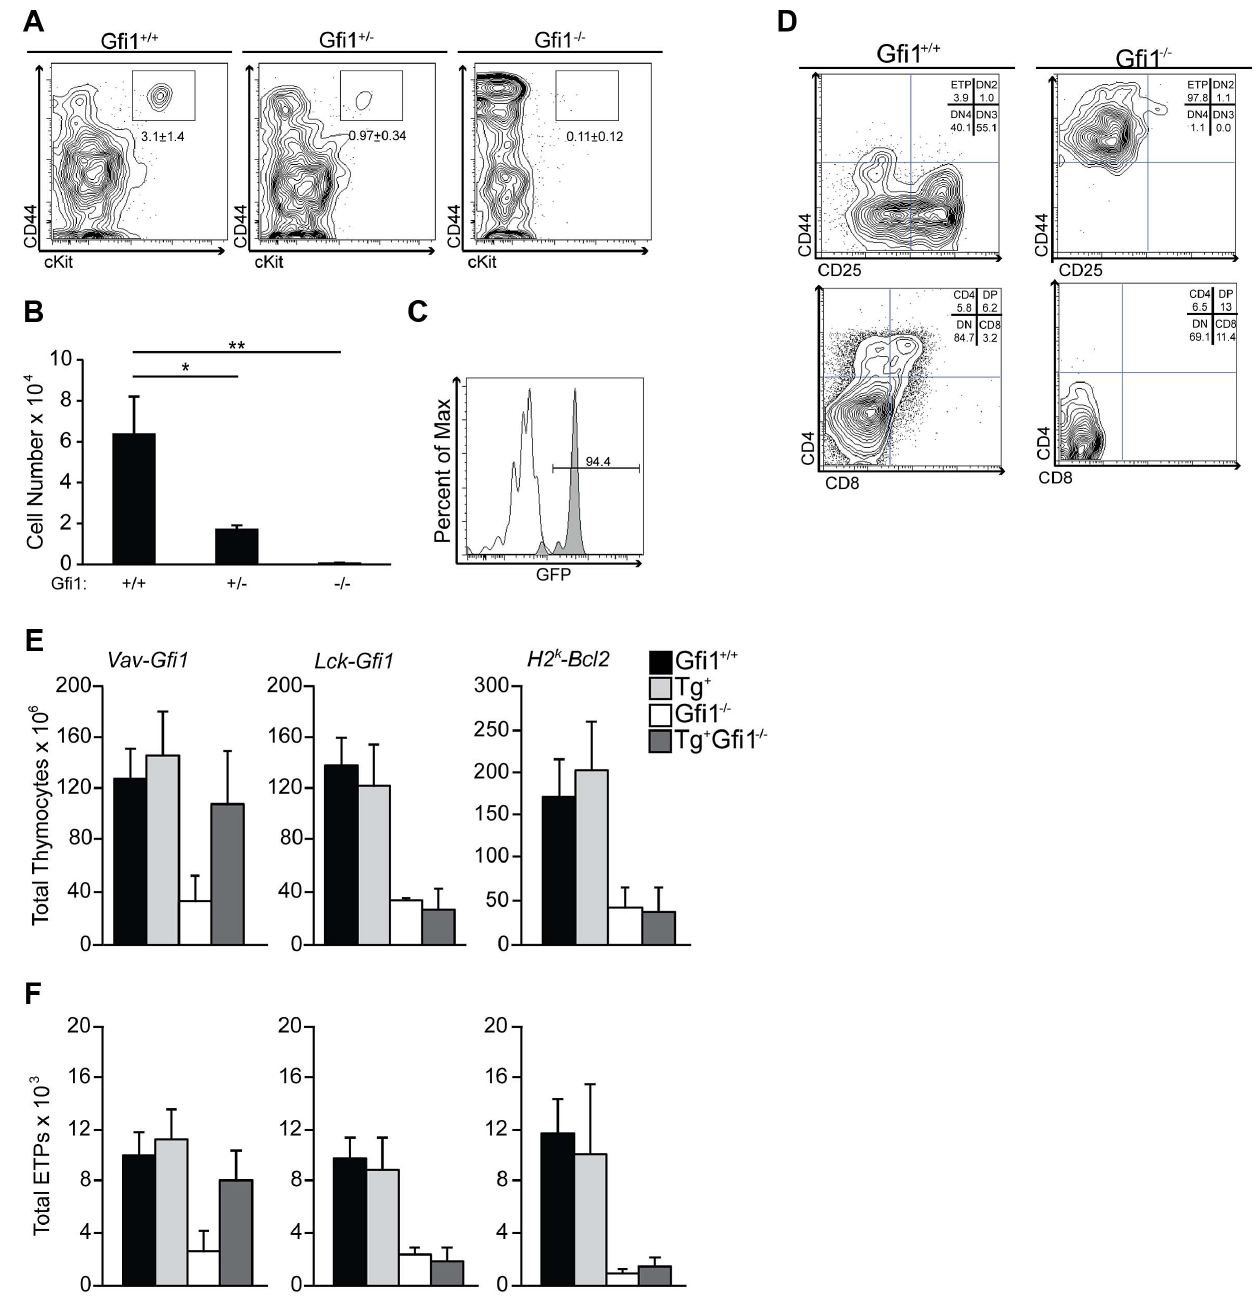
Figure 4. Gfi1 deficiency results in reduced number and function of ETP. (A) Gfi1 + / + (n=4), Gfi1 + / 2 (n=6) and Gfi1 2 / 2 (n=3) thymocytes were analyzed for the percent of Lin 2 , CD25 2 , cKit + , CD44 + ETPs; Average 6 SD. (B) Total cell number or ETPs from (A). (C) Histogram of GFP from Gfi1 GFP/ + knock-in mice (grey shaded peak) compared to Gfi1 + / + littermate control (white peak,) demonstrates Gfi1 expression in ETPs (N=5/ genotype). (D) ETPs were FACS-sorted from Gfi1 + / + and Gfi1 2 / 2 mice directly onto OP9-DL1 stroma and cultured for 15 days. T cell development stages were assessed by flow cytometry. Experiments were repeated three times. One representative example is shown. (E–F) Transgenic rescue of Gfi1 2 / 2 T cell development using Vav-Gfi1 (N=9/genotype), Lck-Gfi1 (N=6/genotype), and H2 K -Bcl2 (N=6/genotype) in Gfi1 + / + and Gfi1 2 / 2 mice. Total thymocyte numbers (E) were calculated and flow cytometry was performed to identify ETPs (F).